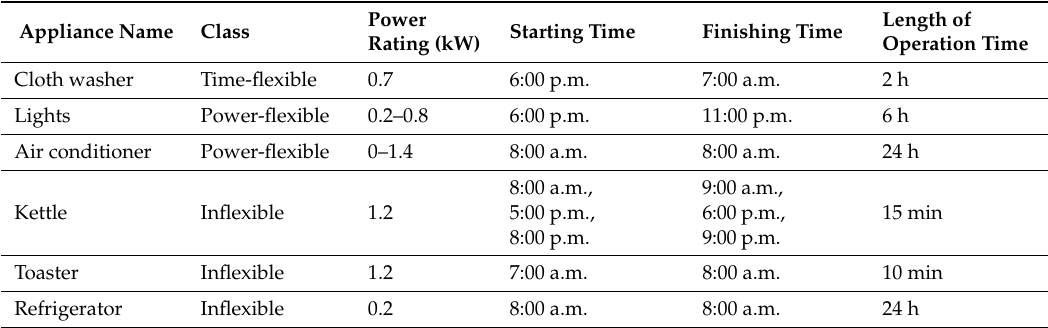
Table 2. Appliances